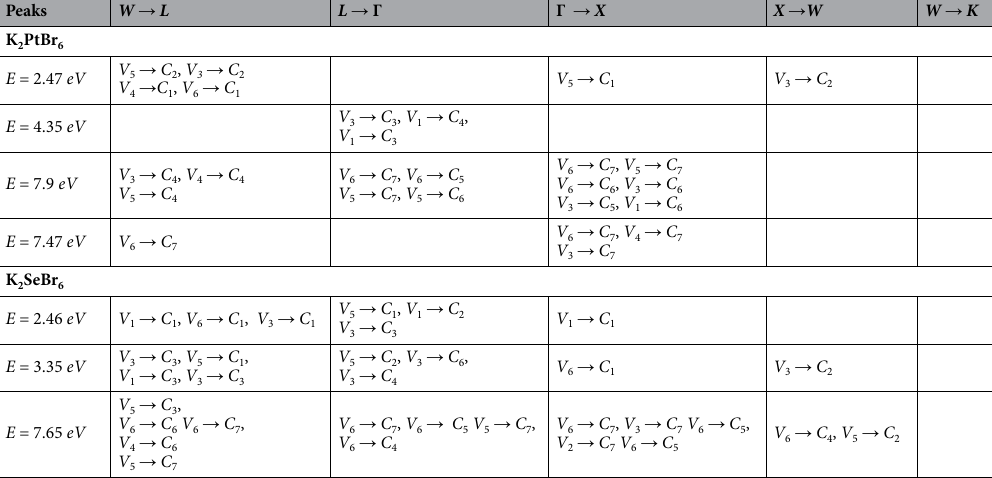
Table 5. The main contribution to the optical transitions for K 2 SeBr 6 (X = Se,